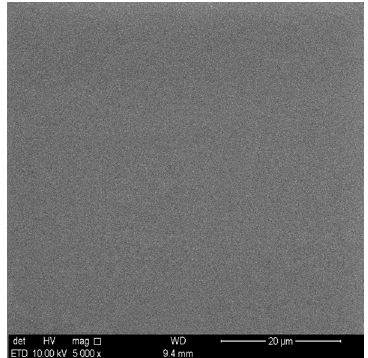
Figure 1. SEM image of Polydimethylsiloxane (PDMS) layer deposited on Ti substrate in negative corona discharge.